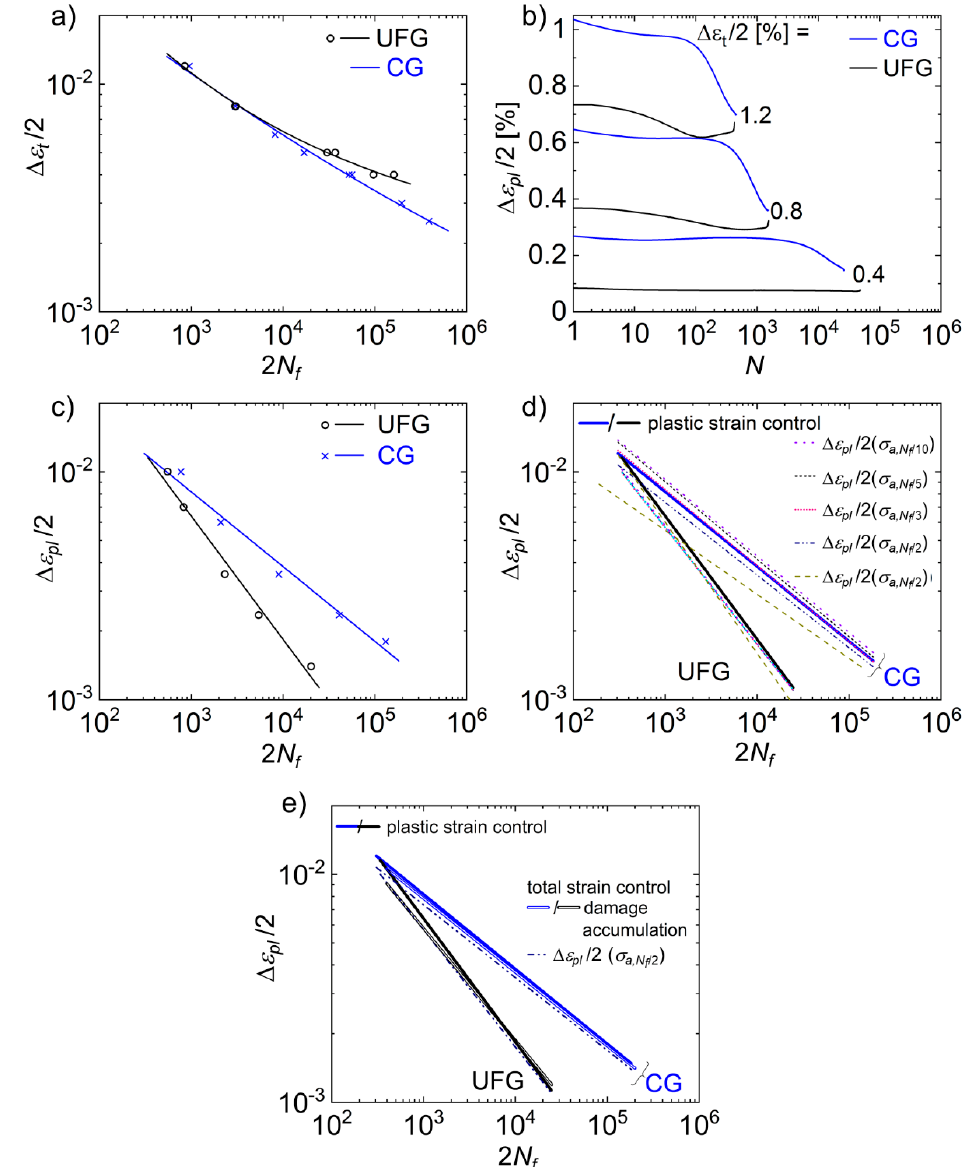
Figure 7. Fatigue life curves of total strain amplitude vs. reversals to failure of UFG and CG conditions ( a ) and evolution of plastic strain amplitude vs. number of cycles ( b ) obtained during total strain-controlled fatigue tests. ( c ) Fatigue lives obtained under plastic strain control for UFG and CG conditions. ( d ) Coffin–Manson plots calculated from total strain-controlled tests using